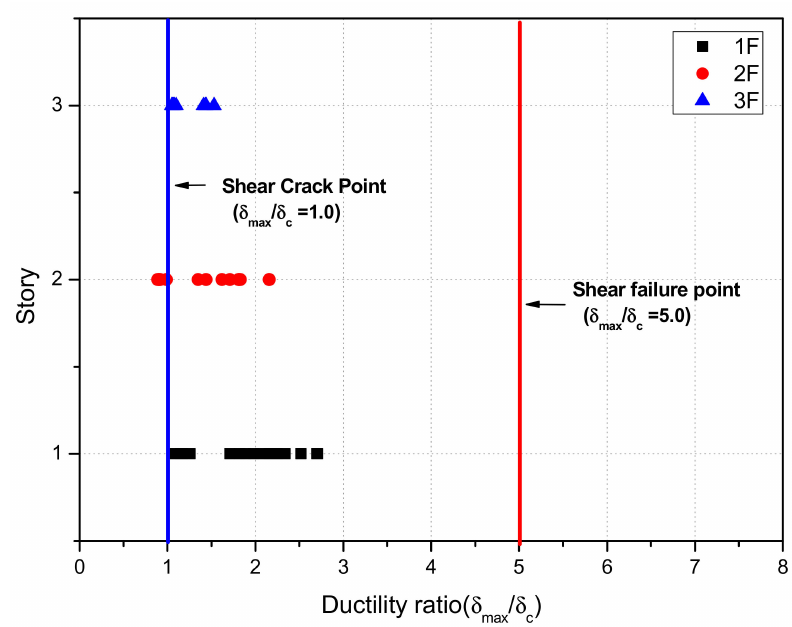
Figure 33. Shear ductility of all column members determined via nonlinear dynamic analysis of the building retrofitted with